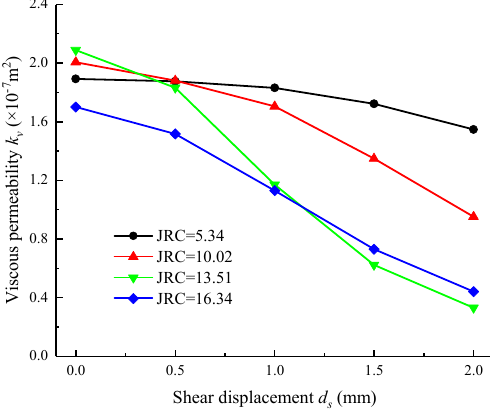
Figure 11. Relationship between intrinsic permeability and shear displacement.